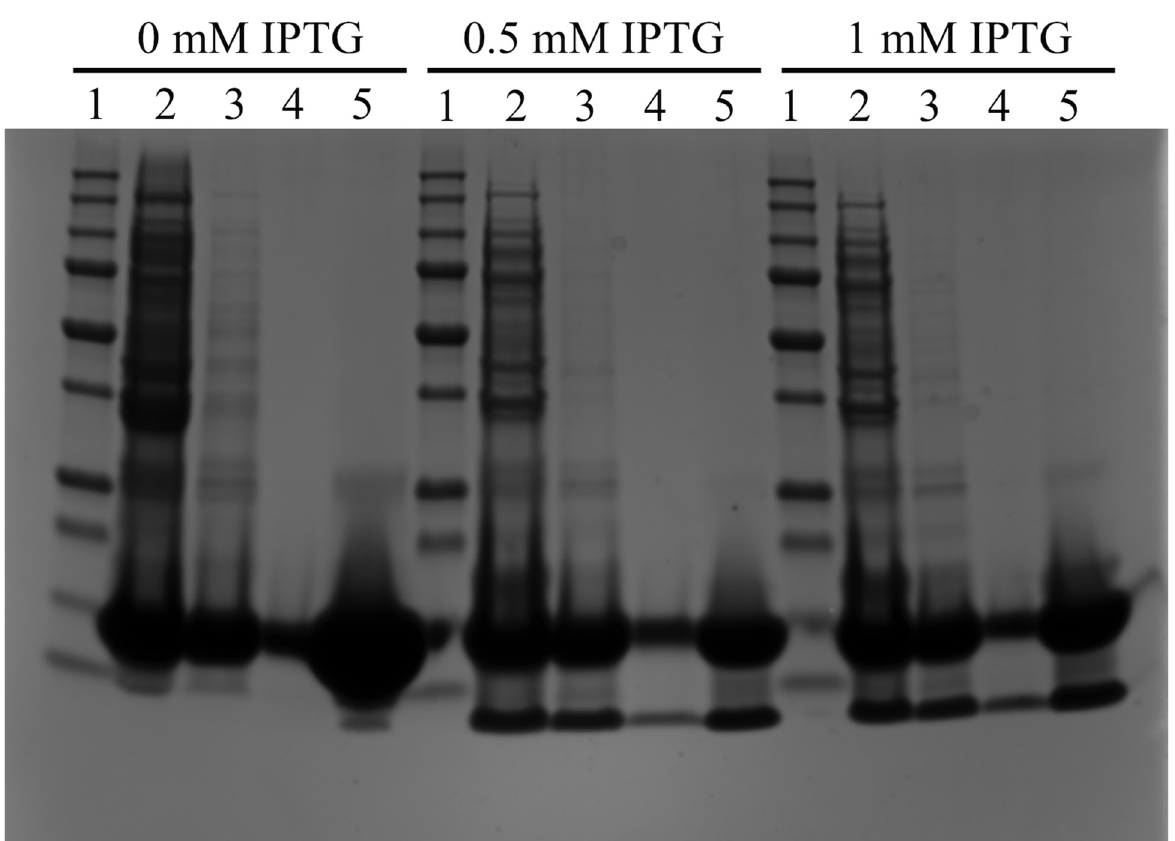
Fig 3. Purification protocol of MA β 1 – 42 IBs dissolved in 8M urea. Lane 1: 10 – 250 kDa protein marker, lane 2: IBs after urea denaturation, lane 3: after passing through DEAE resin, lane 4: after 30-kDa ultrafiltration, lane 5: after 3-kDa concentration.